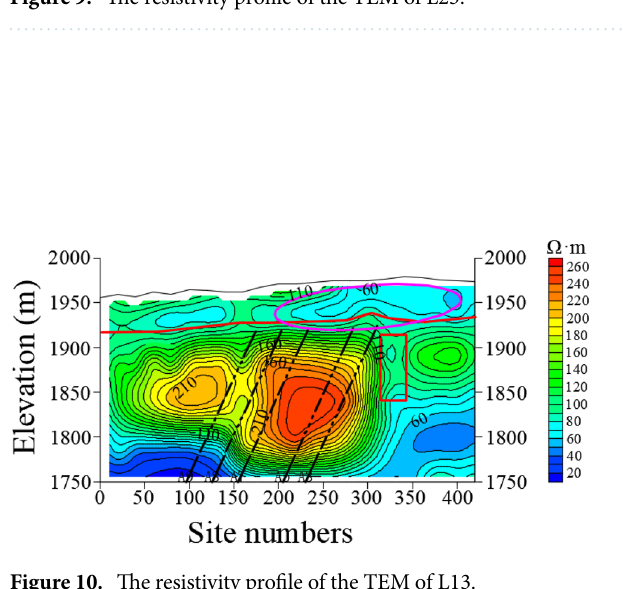
Figure 10. The resistivity profile of the TEM of